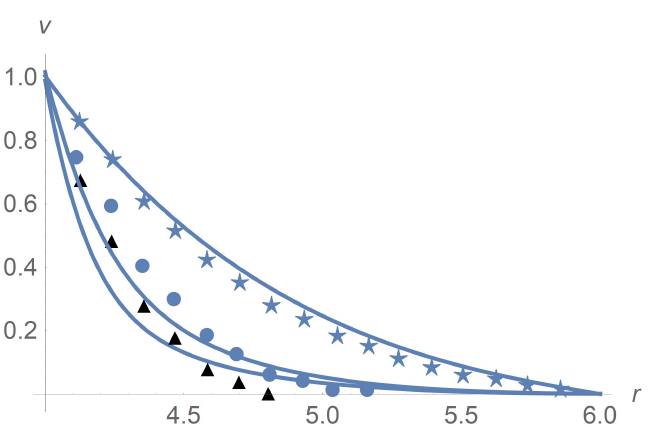
Figure 8. Calculated dimensionless velocity profiles versus the radial variable for φ = 0.3. The lines from bottom upward correspond to Ω = 2 [ rpm ] , Ω = 5 [ rpm ] and Ω = 50 [ rpm ] , respectively. Triangles, balls and stars are the measured data from [9] corresponding to Ω = 2 [ rpm ] , Ω = 5 [ rpm ] and Ω = 50 [ rpm ] ,